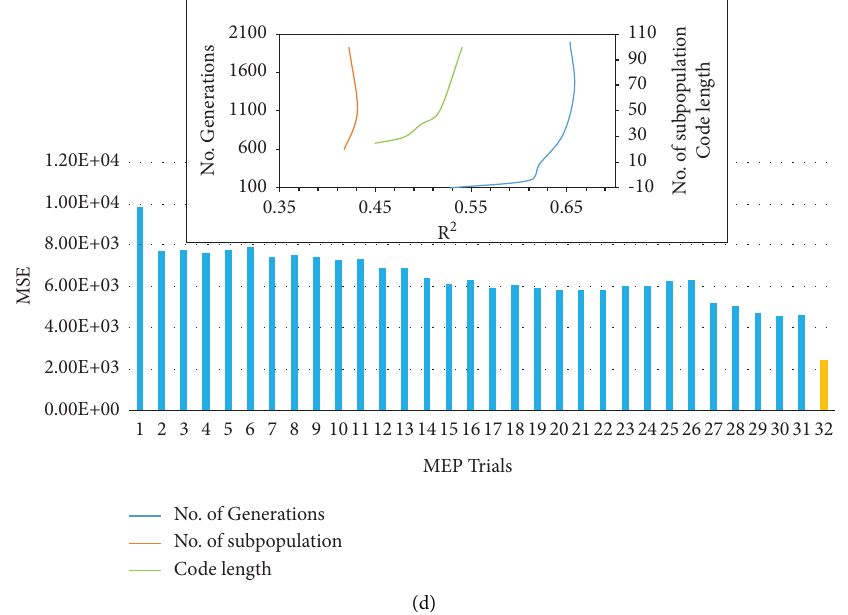
Figure 6: Trials undertaken using GEP and MEP for evaluating optimal genetic-based